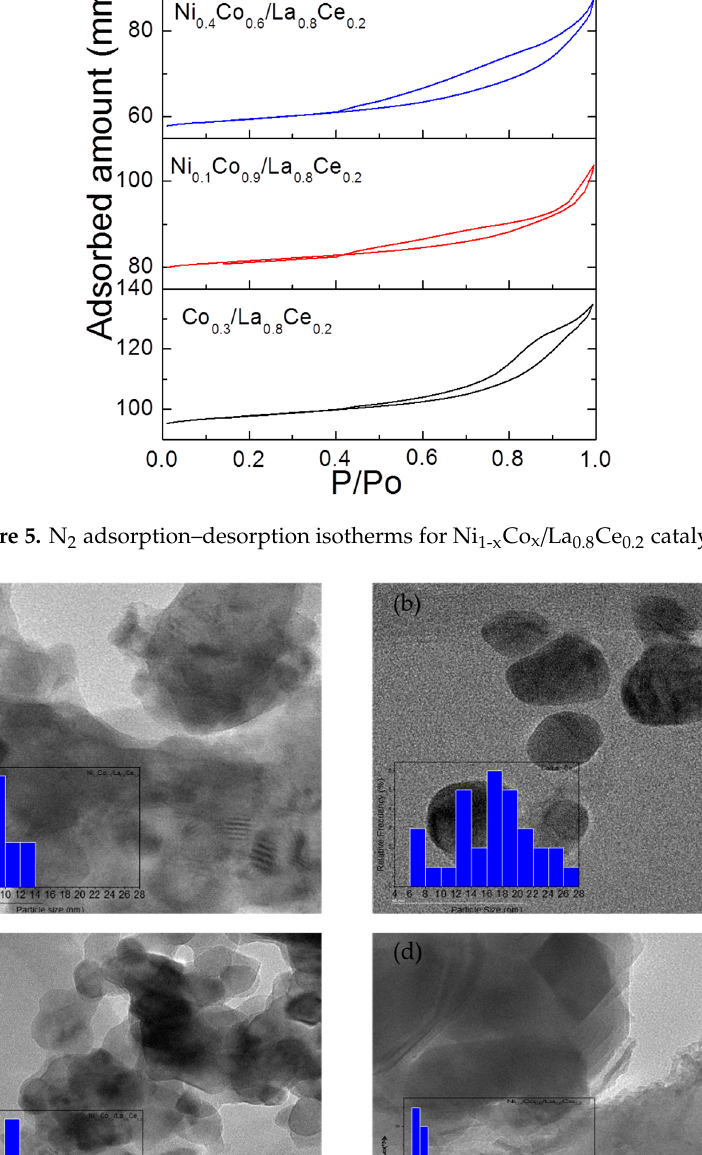
Figure 6. TEM micrographs of Ni 1-x Co x /La 0.8 Ce 0.2 catalysts: ( a ) Ni 0.7 Co 0.3 /La 0.8 Ce 0.2 ; ( b ) Co/La 0.8 Ce 0.2 ; ( c )